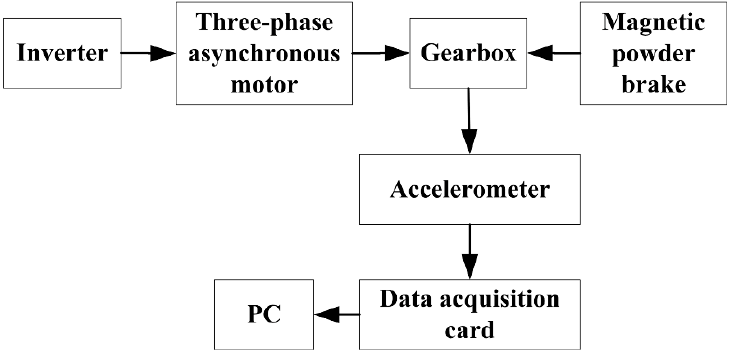
Figure 2. Connection chart of the gearbox experimental device based on the accelerometer.